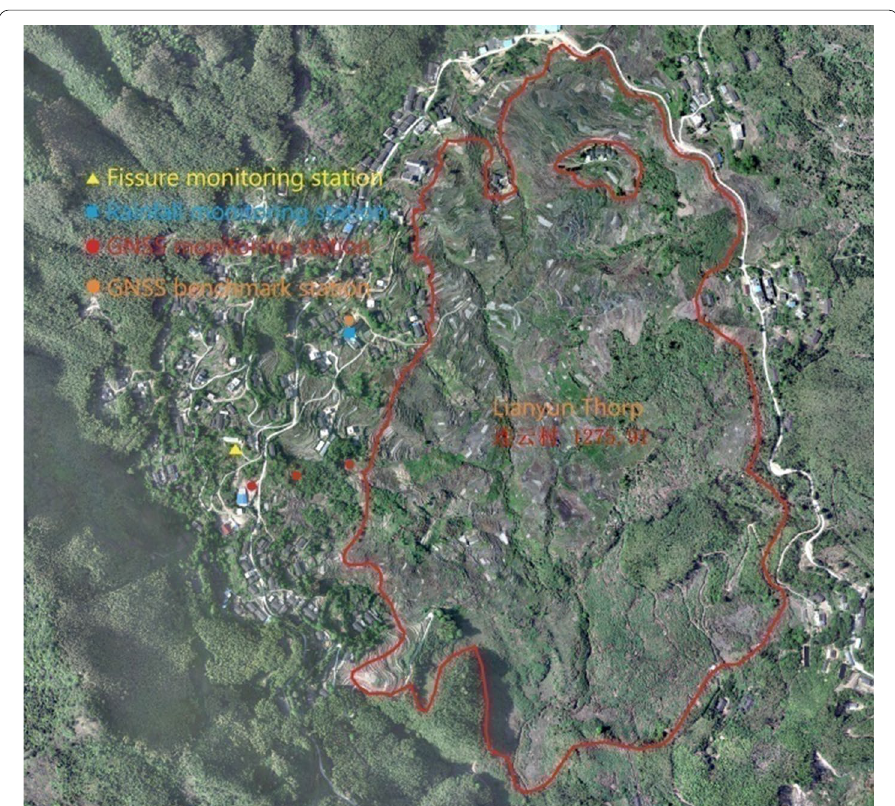
Fig. 10 Schematic layout of landslide monitoring locations